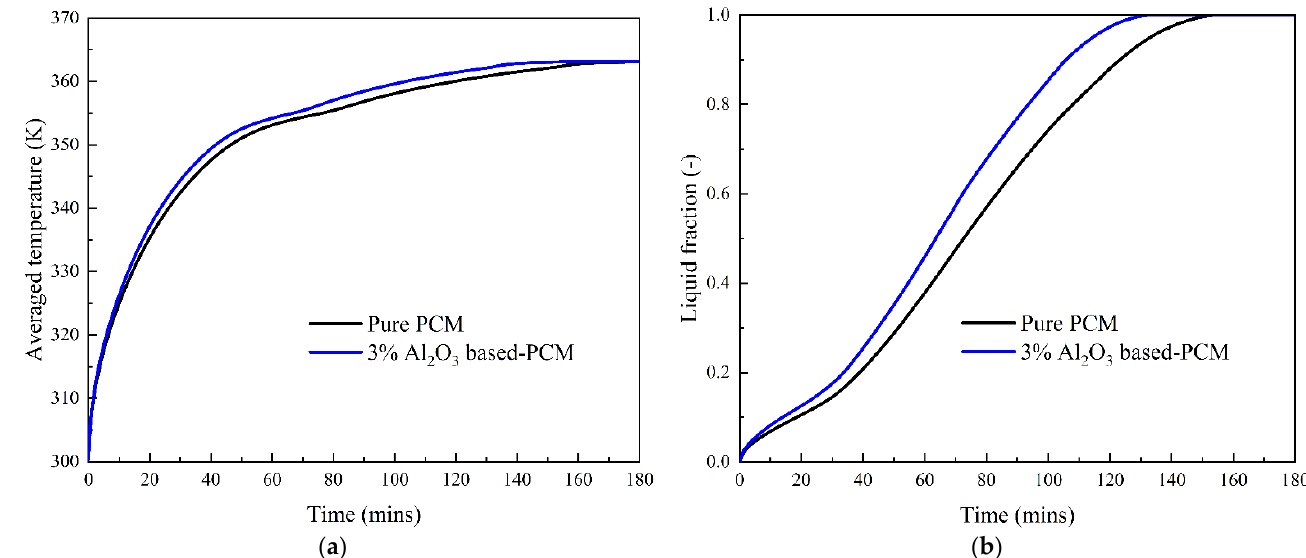
Figure 11. Effect of Al 2 O 3 nanoparticles on the PCM melting process. ( a ) Average temperature; ( b ) Liquid fraction.